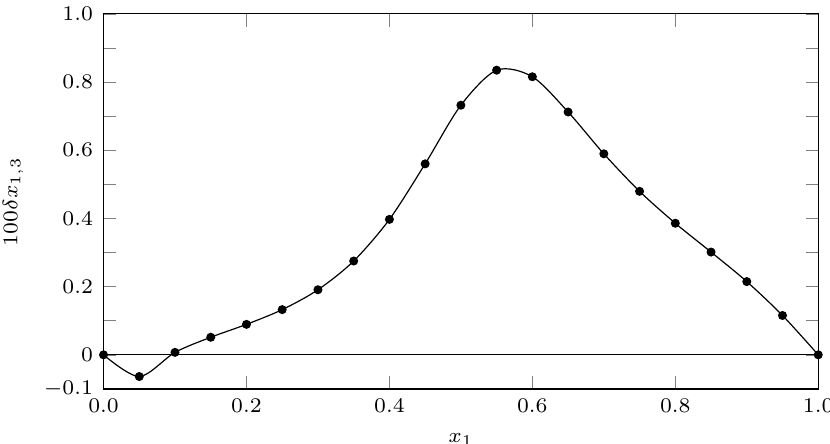
Figure 14. δ x 1,3 values for the isoniazid (3) (PEG 200 (1) + water (2)) cosolvent mixtures at 298.15 K.